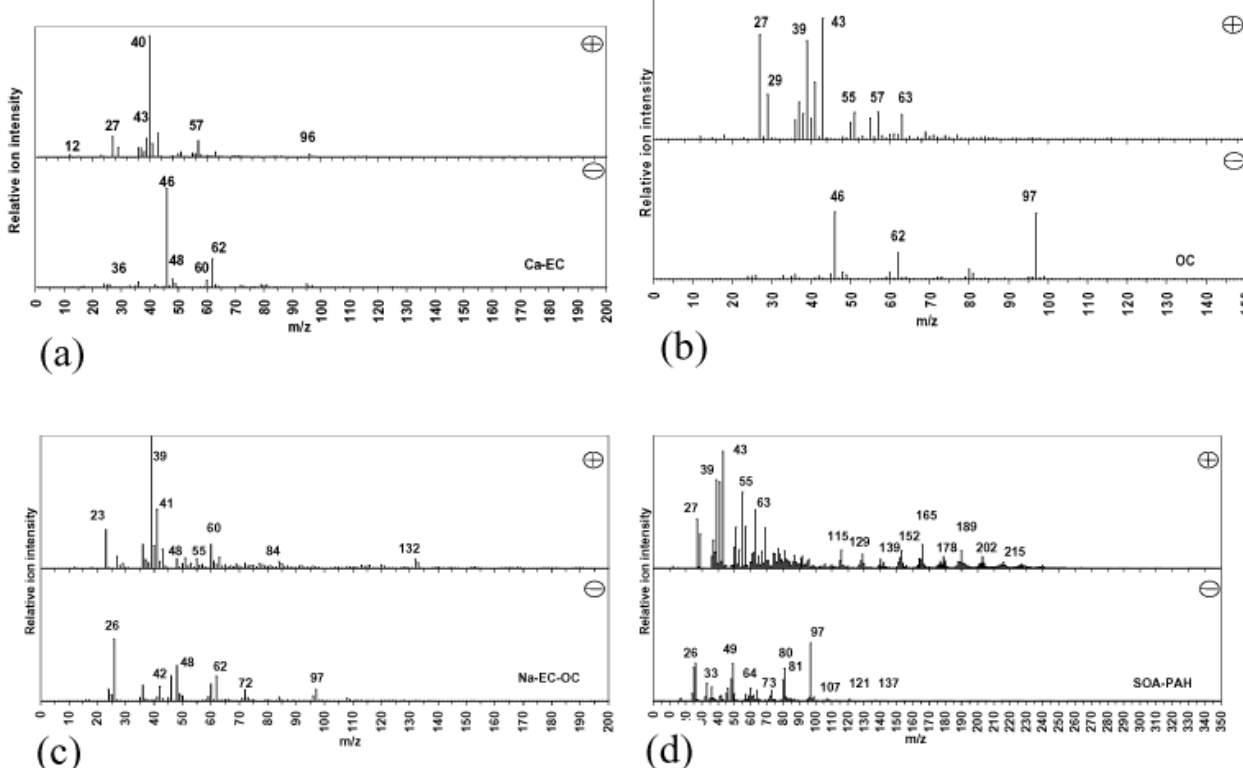
Fig. 1. Positive and Negative ART-2a area vectors attributed to (a) Ca-EC, (b) OC, (c) Na-EC-OC and (d) SOA-PAH.